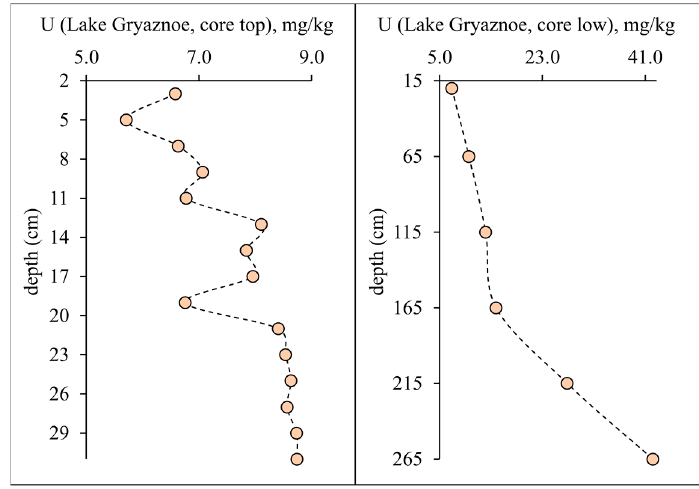
Figure 3. Vertical distribution of U in the sediments of Lake Gryaznoe (Karelia).